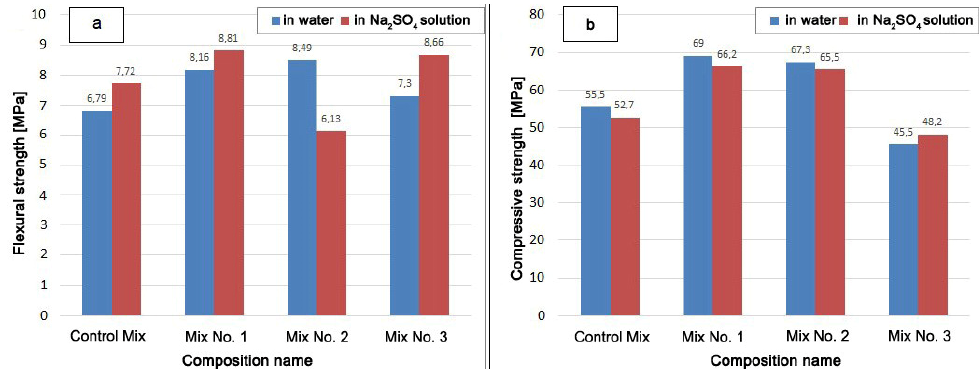
Figure 6. Sample strength after holding in water and in Na 2 SO 4 solution for 340 days: ( a ) flexural